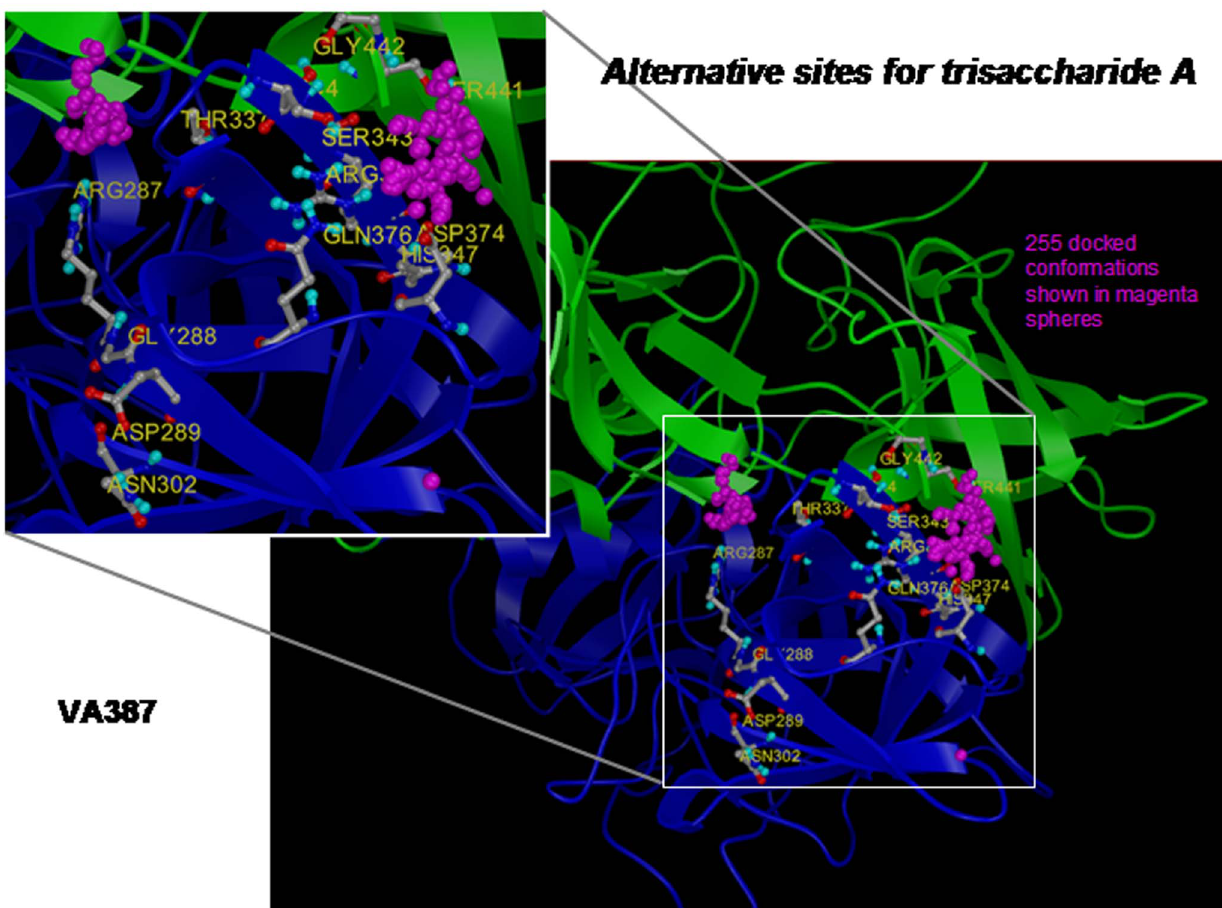
Figure 1. Predicted docking poses for the A trisaccharides docked to the VA387 P dimer clusters at the proved HBGA binding site. The majority of the predicted poses (each represented by a magenta ball) docked to the experimentally resolved HBGA binding site that was formed by Ser343, Arg345, His347, Asp374, Gln376, Ser441 and Gly442 (circled by a yellow dashed line). Some of the poses docked to a nearby site that was previously suggested as an alternative binding site for HBGA (Tan et al., 2003). The structure of the P dimer of VA387 (2OBS) is shown using ribbon model, each monomer in green and blue, respectively. The amino acids that constitute the experimentally mapped HBGA binding site were shown using stick model and circled by a yellow dashed line, while amino acids forming the nearby site were also shown in stick model. The squared region containing the HBGA binding site is enlarged in the up-left panel.